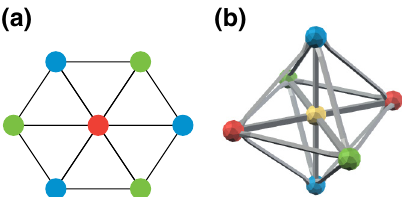
FIG. 9. (a) A colorable 2-ball and its boundary. The colorable 2-ball consists of the central r vertex and all simplices containing it. The boundary consists of the b and g vertices, alongside the edges connecting them. (b) A 3D colorable 3-ball and its bound- ary. The colorable 3-ball consists of the central yellow vertex and all simplices containing it. The boundary consists of the r , g , and b vertices, alongside the triangles and edges the vertices of which are subsets of these